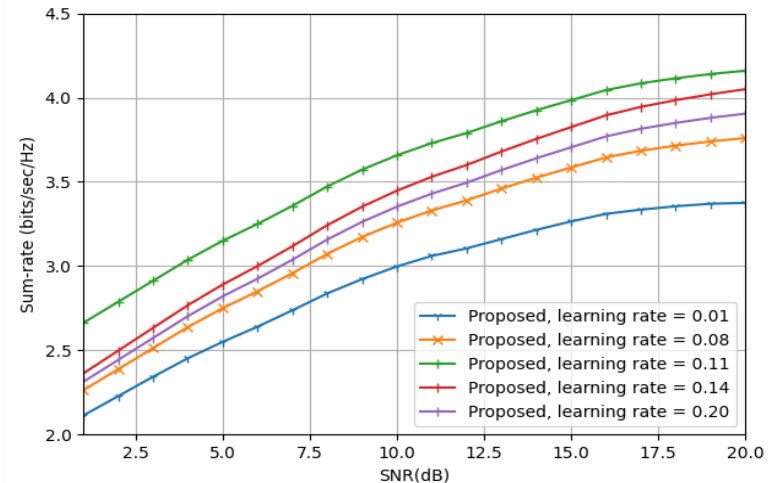
Figure 10. Sum rate versus SNR for the proposed CNN-based SIC scheme with varying learning rates.